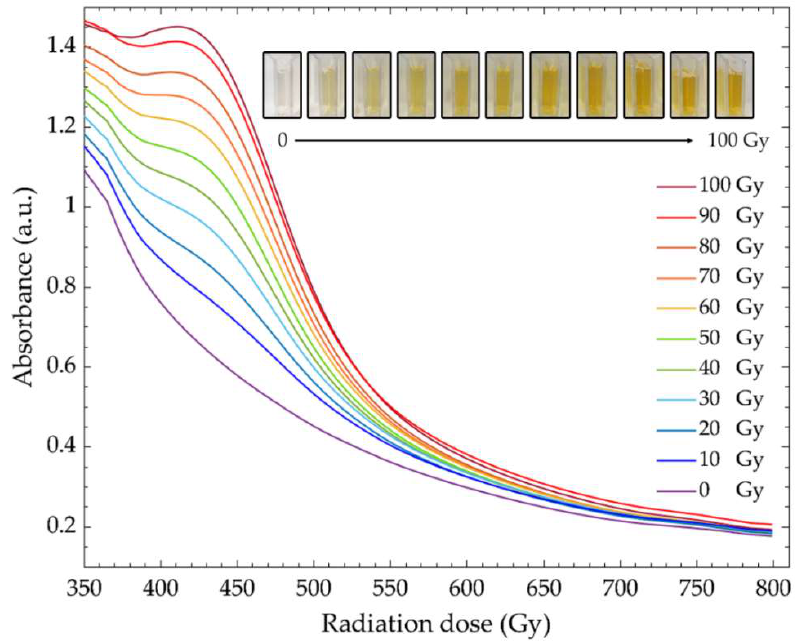
Figure 1. Principle of the colorimetric sensor based on a hybrid PVA/AgNPs: ( a ) before and ( b ) after gamma irradiation.